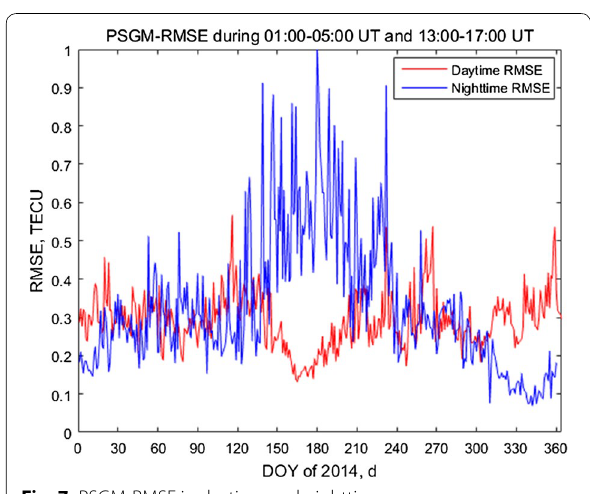
Fig. 7 PSGM-RMSE in daytime and